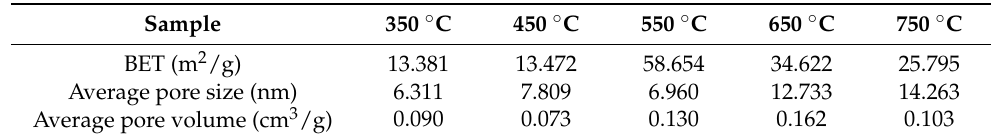
Table 1. BET surface area, average pore size, and pore volume of B-TiO 2 /C 3 N 4 material at different temperatures.